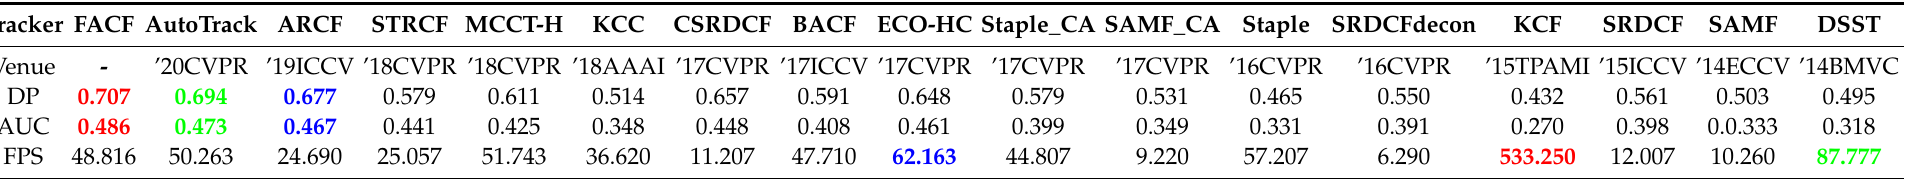
Table 1. Average performance of all trackers on benchmarks DTB70 [25], UAV123@10fps [26], and UAVTrack112 [27]. Red , green , and blue represent the top three trackers in terms of DP, AUC, and FPS,